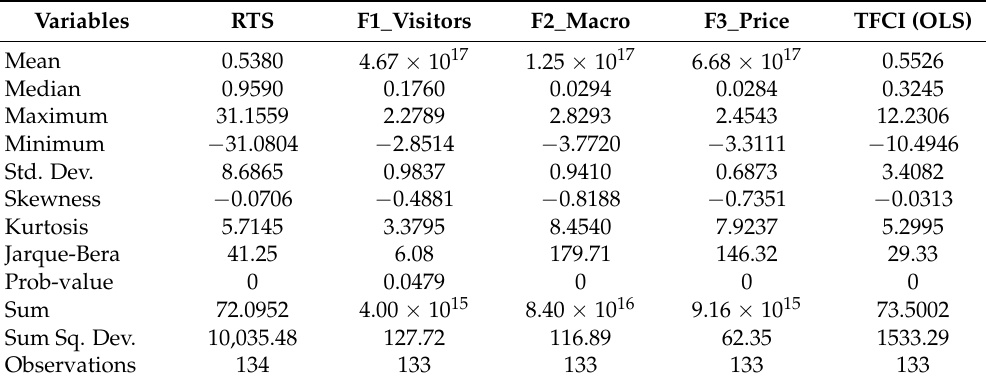
Figure 1. Time series of tourism variables (April 2005–June 2016). Table 2. Descriptive statistics of variables for April 2005–June